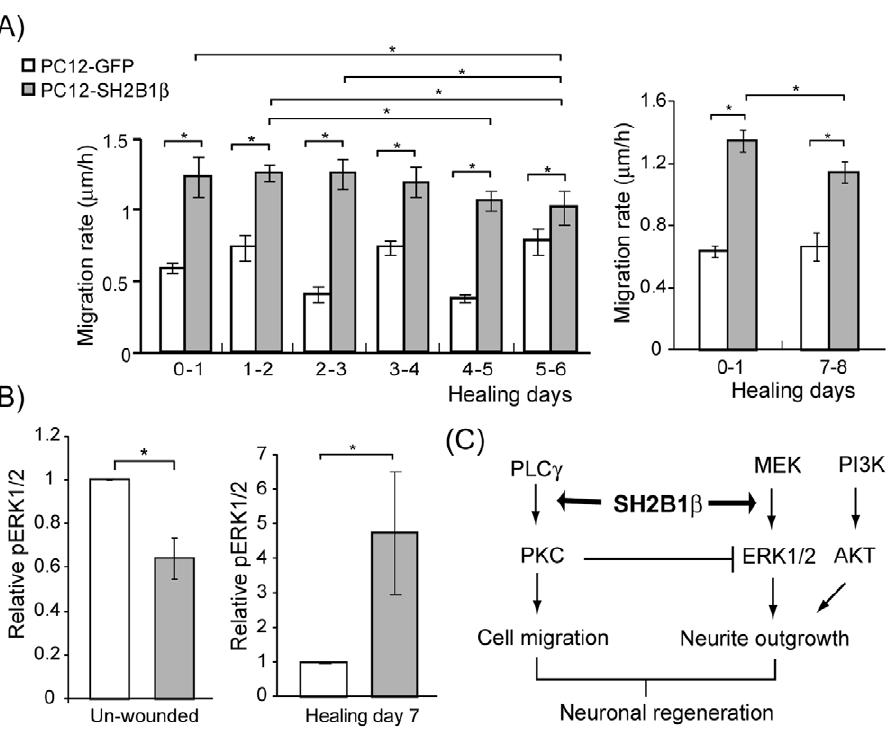
Figure 9. Motility of cells overexpressing SH2B1 b is higher during healing days 0 – 4 and reduced during healing days 5 – 8. PC12-GFP and PC12-SH2B1 b cells were differentiated and subjected to wound healing as described in Figure 1. (A) Cell migration was tracked every day and the net distance per day was calculated. Values are mean 6 S.E.M. from four independent experiments for healing days 0–6 (left panel) and three independent experiments for healing days 0–1 and 7–8 (right panel). (*: P , 0.05, paired Student’s t-test) (B) Relative pERK1/2 levels were normalized to total ERK1/2 and then the levels in PC12-GFP cells on differentiated day 8 (Un-wounded) or on healing day 7. Values are mean 6 S.E.M. from eighteen independent experiments for un-wounded cells and four independent experiments for healing day 7. (*: P , 0.05, paired Student’s t-test) (C) SH2B1 b modulates PKC-dependent cell migration and ERK1/2-mediated neurite re-growth depending on the healing stages. PKC-dependent cell migration antagonizes ERK1/2-mediated neurite re-growth, and fine temporal regulation of cell migration and neurite re-growth contributes to the optimal healing outcome.